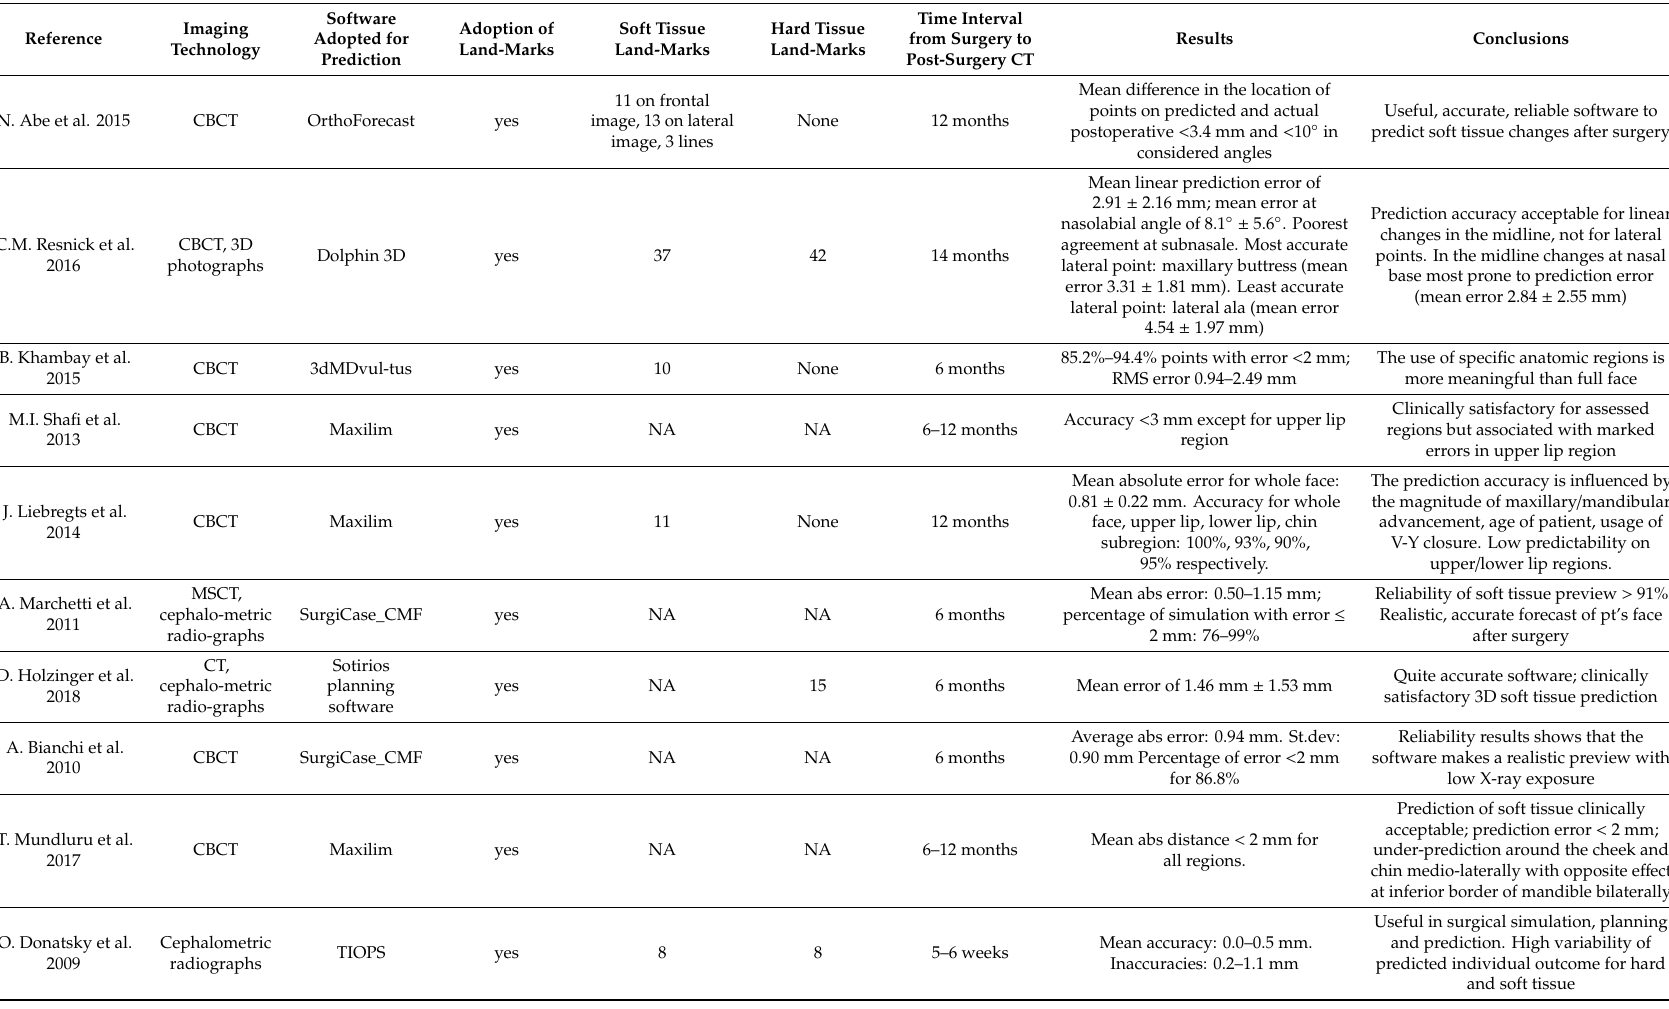
Table 3. Imaging technology, software used for prediction, number of landmarks for soft tissue and hard tissue, time interval from surgery to post-operative imaging and